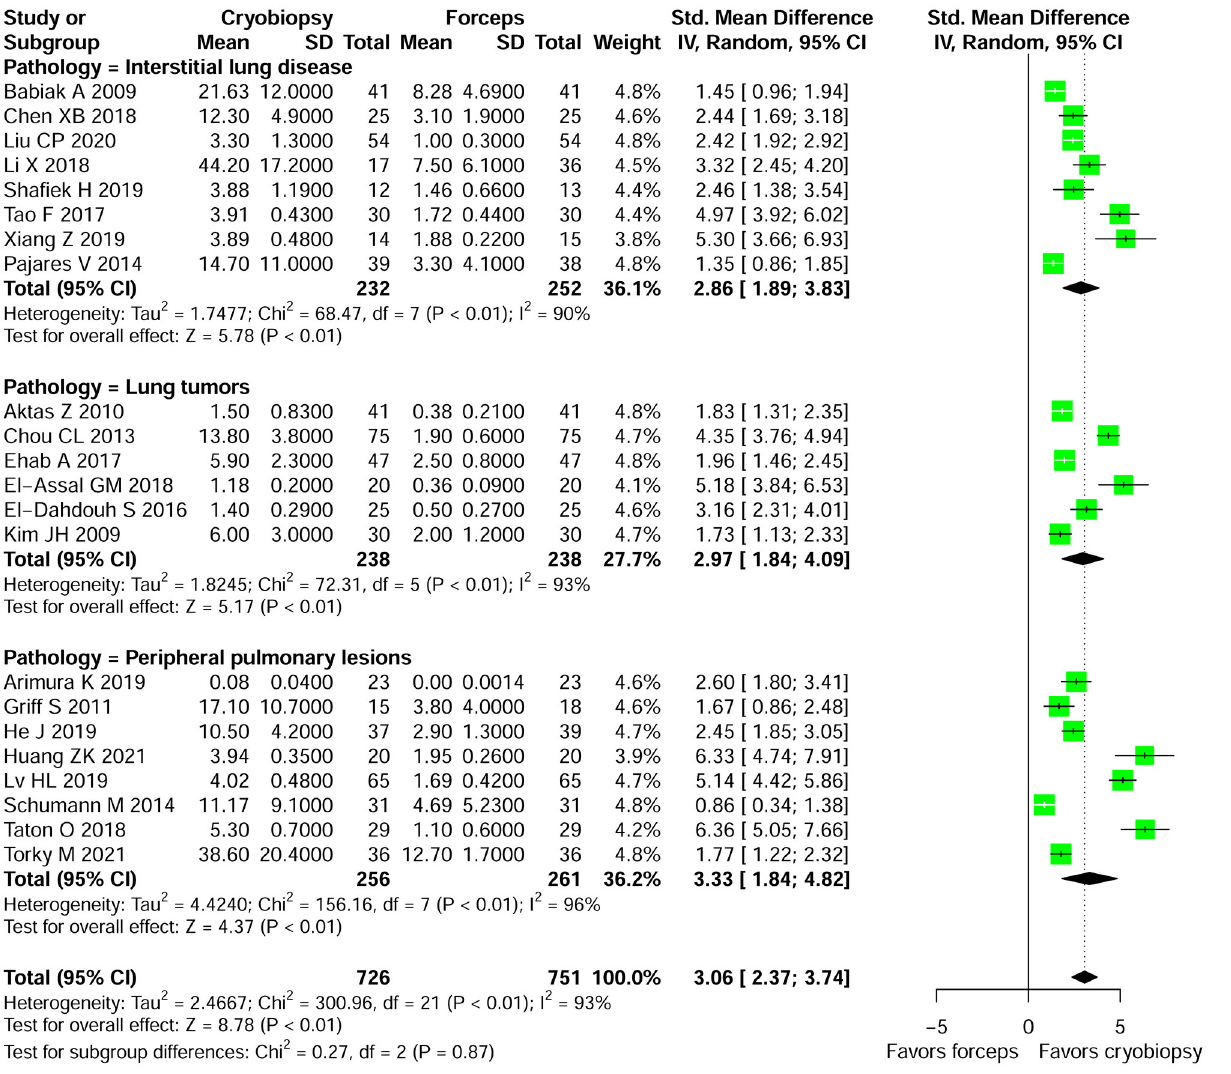
FIGURE 3 | Forest plot of specimen size obtained by cryobiopsy and forceps biopsy. Subgroup analysis stratified by lung pathologies (such as, ILDs, lung tumors, and PPLs) showed that there were significant differences in specimen size between the cryobiopsy and forceps biopsy in all three subgroups ( p < 0.01). CI, confidence interval; SD, standard deviation; SMD, standardized mean